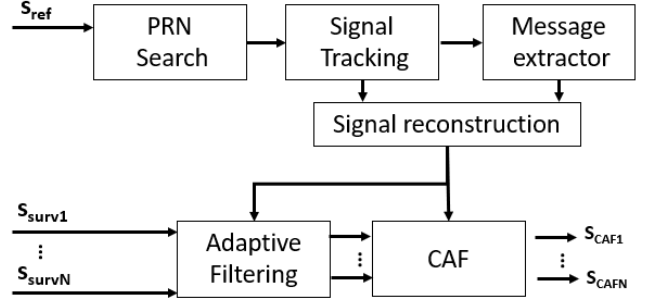
Figure 2. Signal processing schema based on GPS signal regeneration, adaptive filtering and